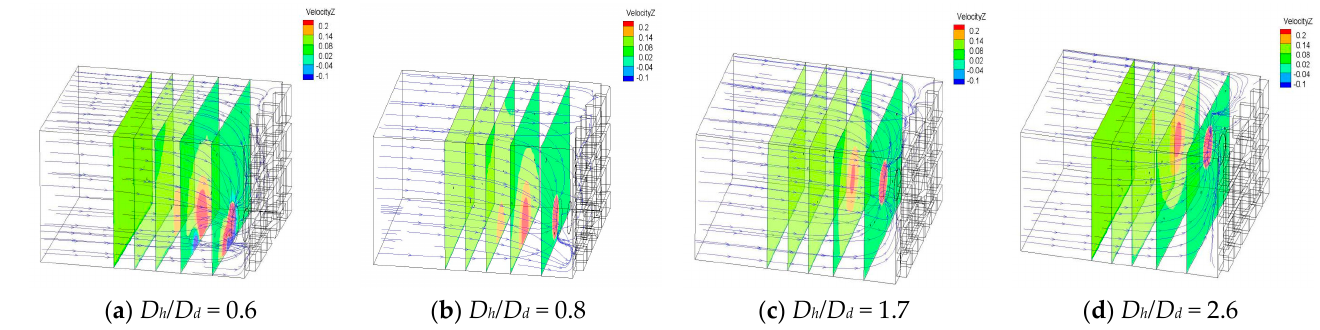
Figure 13. Suction sump of different sections of the axial flow velocity distribution (sections 2-1~2-5, unit: m/s).